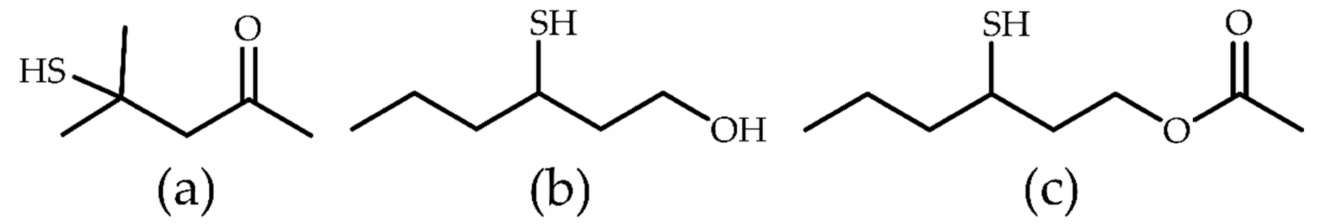
Figure 2. Volatile thiols found in Sauvignon Blanc wines. ( a ) 4-mercapto-4-methylpentan-2-one,